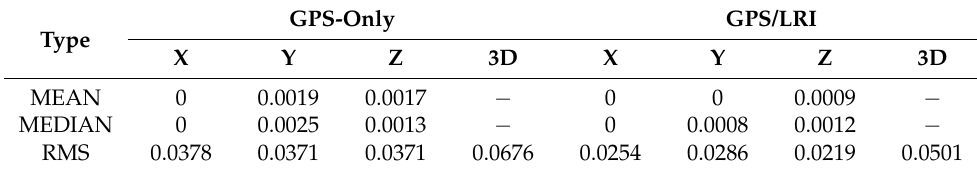
Table 5. Statistics of reference orbit check (days 121–242) in Earth-fixed coordinate (unit: m).